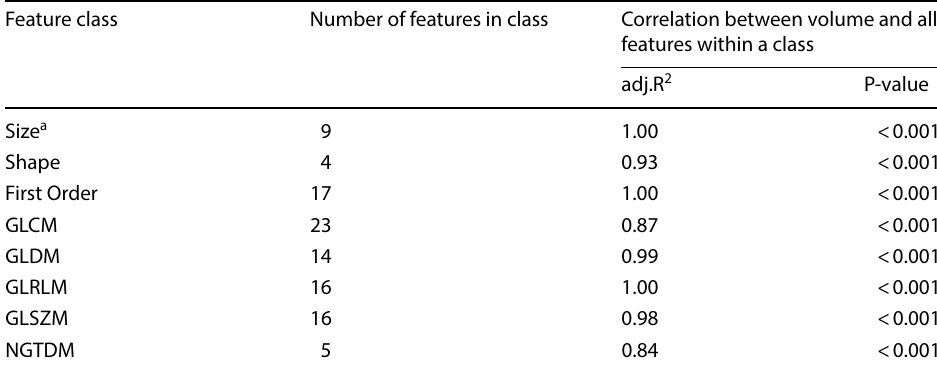
Table 3 Correlation of lung voxel volume with perfused lung radiomic features within each feature